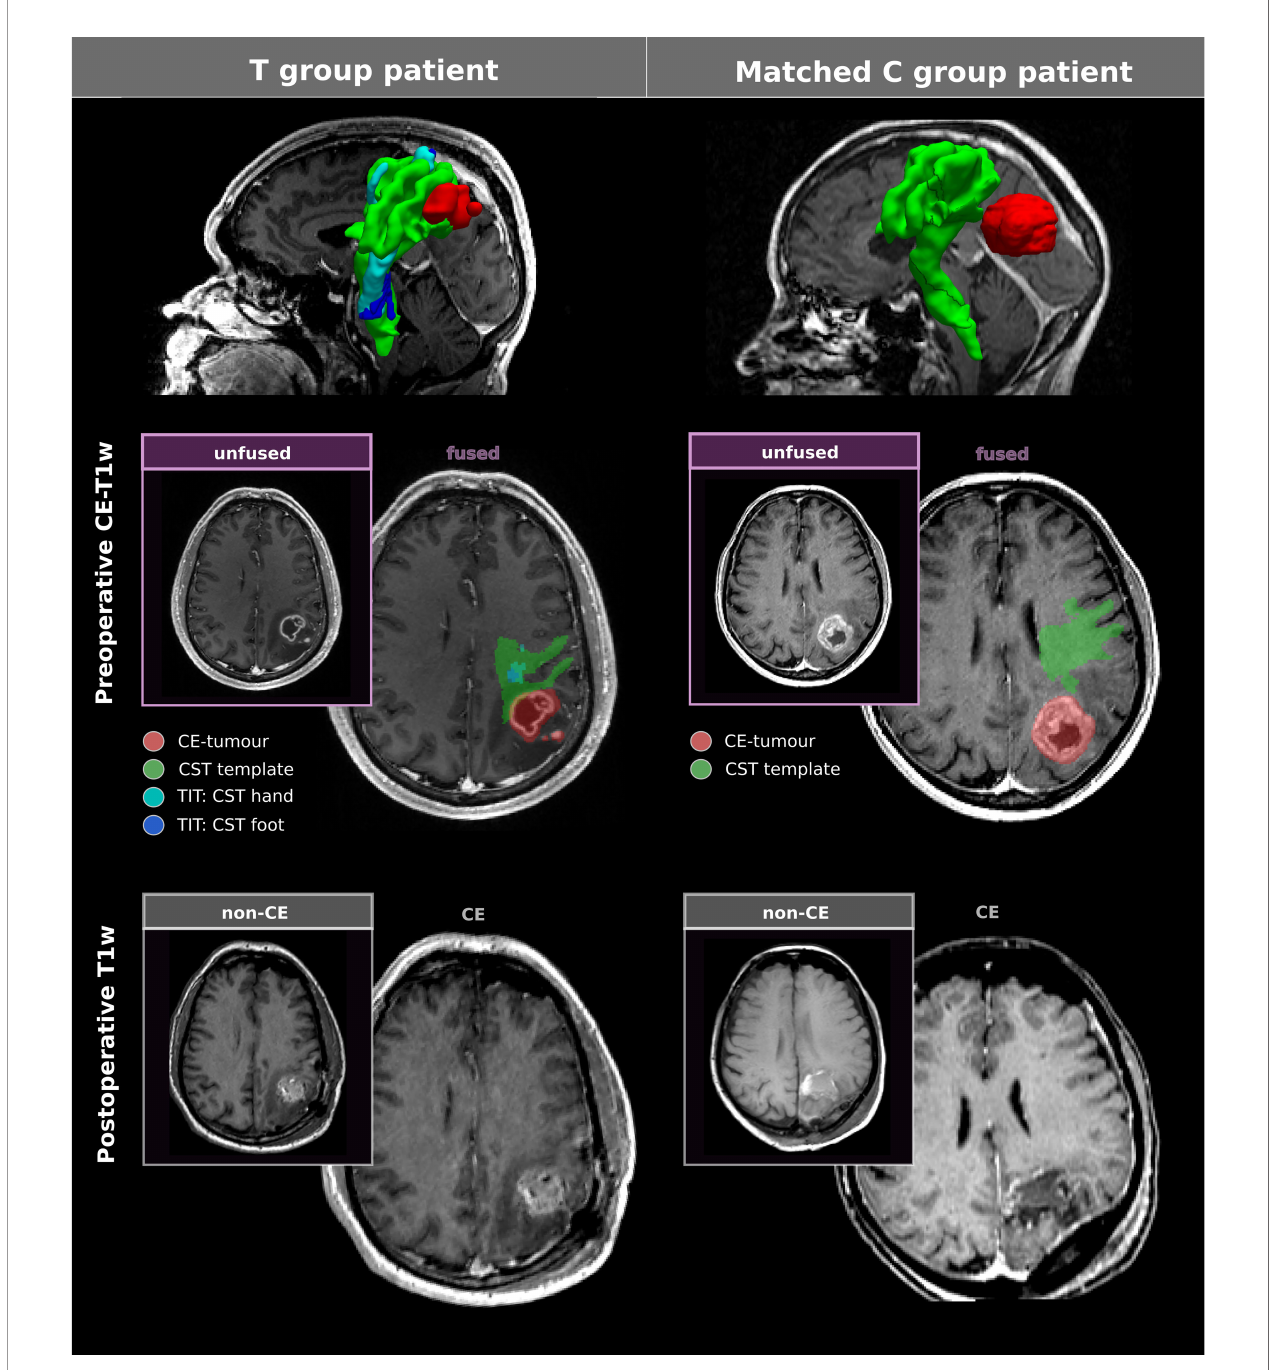
FIGURE 2 | Illustration of clinical and experimental methodology. To investigate the in fl uence of TIT on GTR, patients from group T (TIT) and control group C were pairwise matched according to the CE-tumour volume (PTV) and the insula-overlap. The fi gure illustrates the clinical and methodological imaging results in a PSM- paired couple of patients (IDs 35 and 48; Supplementary Table S1 ). In patients from group T (left), somatotopic CST fi bres (cyan: hand; blue: foot) were reconstructed using TIT and were integrated in the neuronavigation system for surgery planning and intraoperative guidance. For a standardised assessment of tumour eloquence across groups, a probabilistic standard CST template (green) was used to compute the CST-overlap, i.e., the proportion of the CST template overlapped with the tumour volume (red). Case 35 (left): 50 year-old male patient presenting with focal motor seizures and coordination de fi cits responsive to oral antiepileptic and anti-oedematous drugs who underwent GTR aided by TIT, 5-ALA and DCS without postoperative gross motor de fi cits (PFS 7.3 months; OS 10.0 months). Case 48 (right): The 78 year-old female patient without preoperative motor de fi cits underwent GTR guided by neuronavigation and 5-ALA fl uorescence without postoperative gross motor de fi cits (PFS 5.8 months; OS 8.6